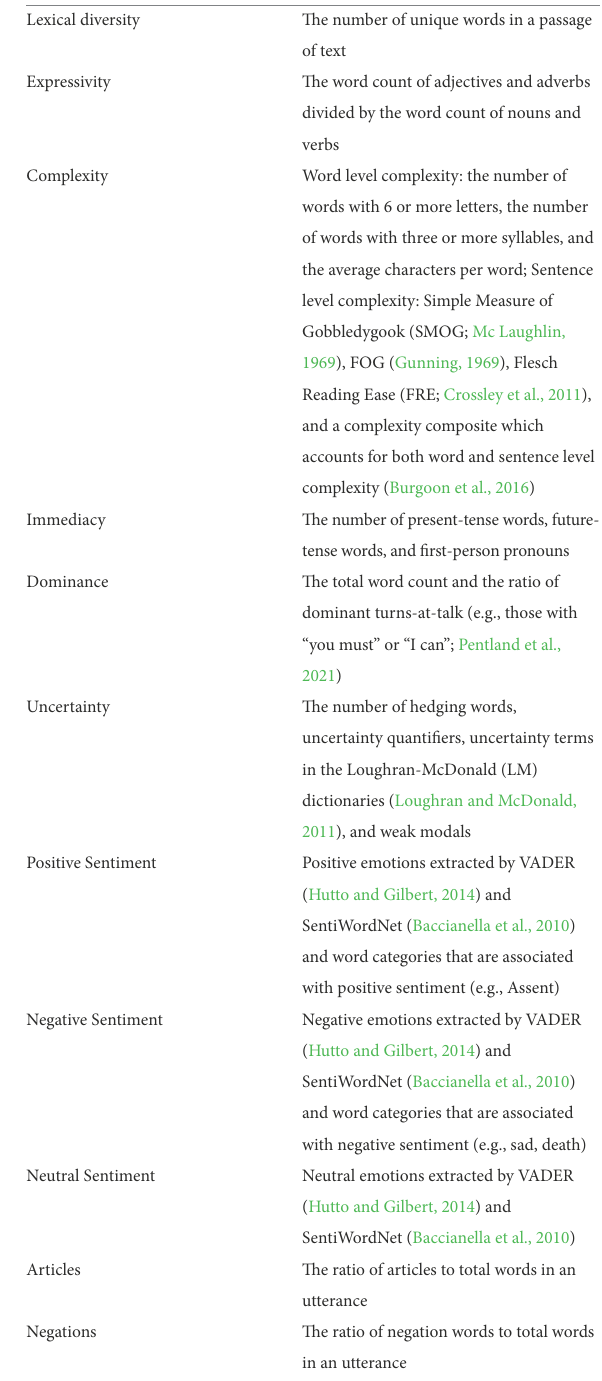
TABLE 1 Measurement of language variables in the